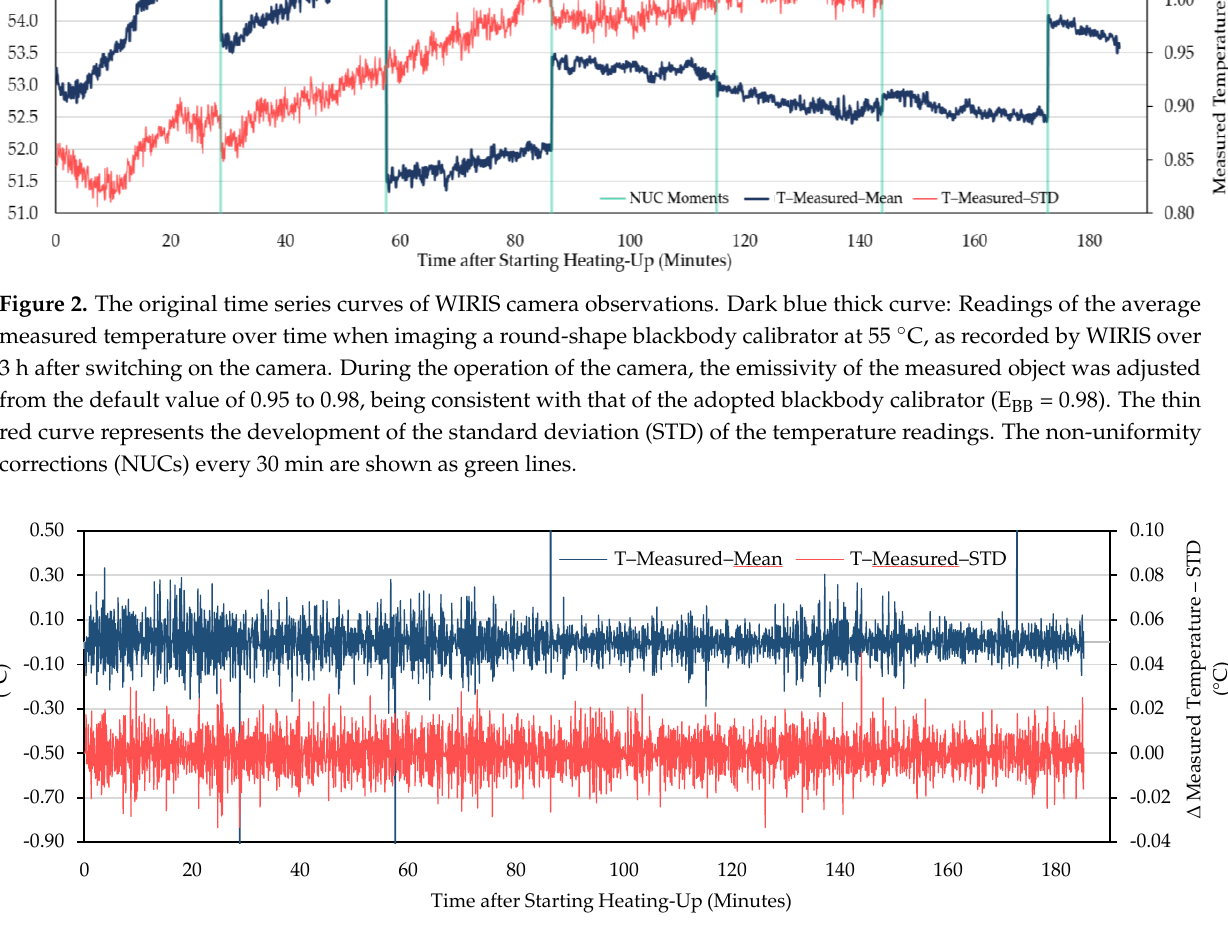
Figure 5. The measured average temperature of the blackbody (55 °C) area, as recorded by WIRIS 2nd GEN over 2 h after activation. The STD of the measured temperature is also included. In this session, the automatic NUCs were enabled every 30 min. This figure is used as a comparison with Figure 4 to visualize the influence of NUC frequency under the same experimental conditions. Due to a malfunction, no data was recorded between 17 and 28 min. Figure 6. The measured average temperature of the blackbody calibrator (55 °C) area, as recorded by FLIR E8-XT over 1 h after switching on the camera. The housing temperature’s development of the camera is also depicted.